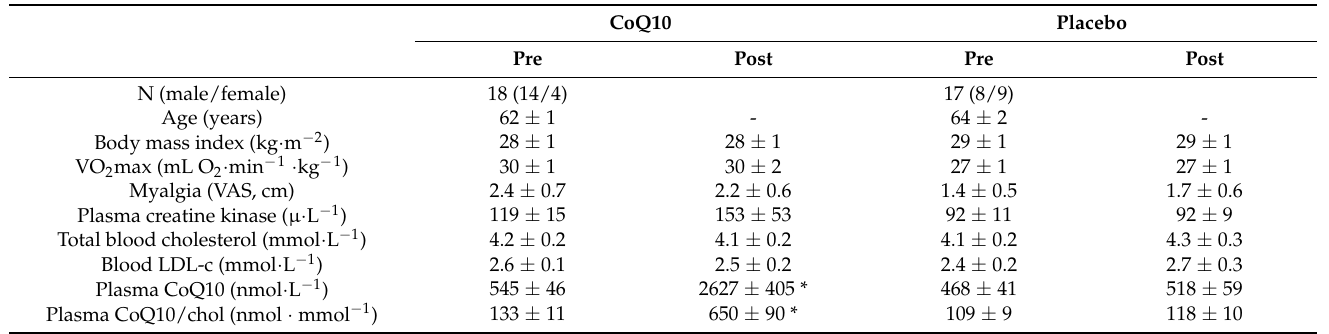
Table 1. Patient